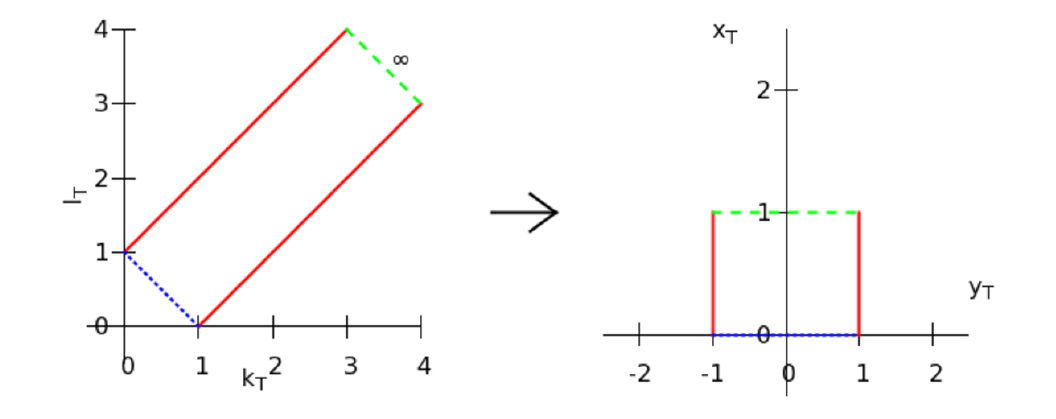
Figure 12 . The integration region in the transverse coordinates before (left) and after (right) the transformation of variables from Step 1 discussed in section